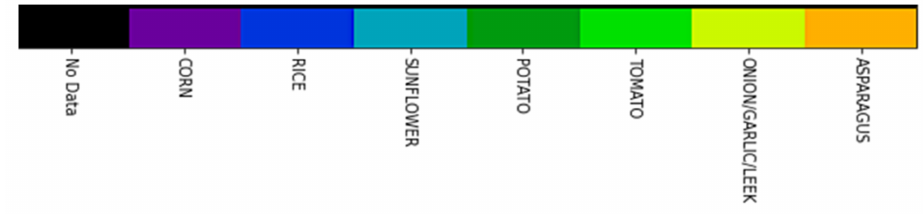
Figure 12. Colour scale of categories.